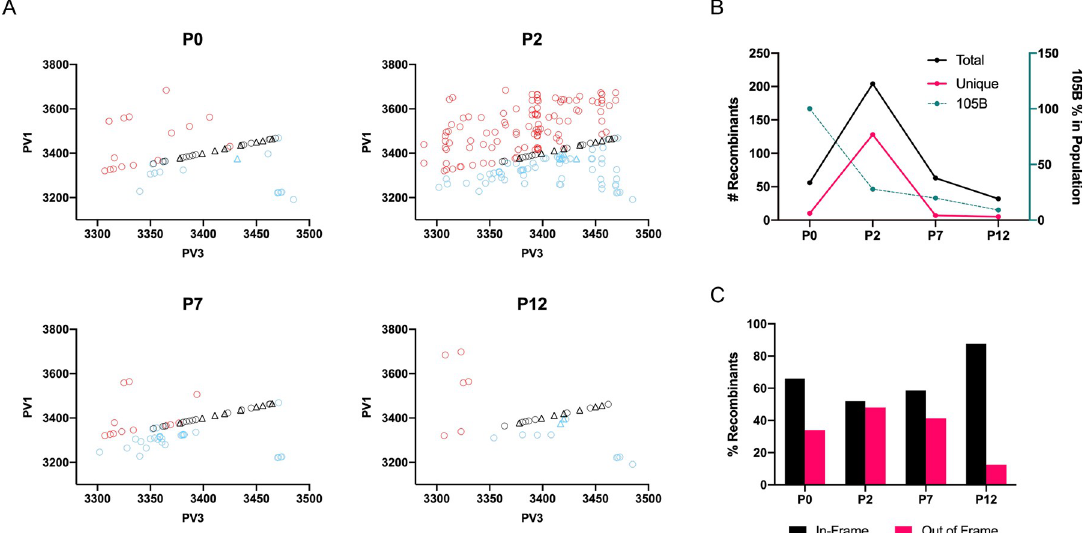
Fig 5. Visualisation of #105B Illumina recombinant type. (A) Recombinants detected via Illumina sequencing were plotted by type for p0, p2, p7, and p12; precise (open black circles), imprecise-insertion (open blue circles) or imprecise-deletion (open red circles). All recombinants detected with Oxford Nanopore as well as Illumina sequencing, irrespective of passage number, are indicated as precise (open black triangles) or imprecise-insertion (open blue triangles) recombinants. (B) Recombinant counts. The total number of independent junctions at each passage (left Y axis) was plotted against the passage number (x-axis) highlighting the level of diversity within the population at each passage. The proportion of #105B at each passage was plotted as a percentage of the total reads for #105B at p0 and after normalisation of all reads to p0 (right Y axis). (C) Comparison of the percentage of in-frame and out-of-frame recombinants present at each passage.